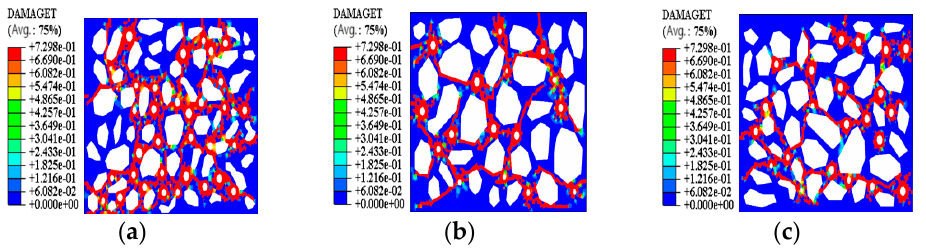
Figure 10. Comparison of damage nephogram of model 1–3 with test results. ( a ) Model 1; ( b ) Model 2; ( c ) Model 3.